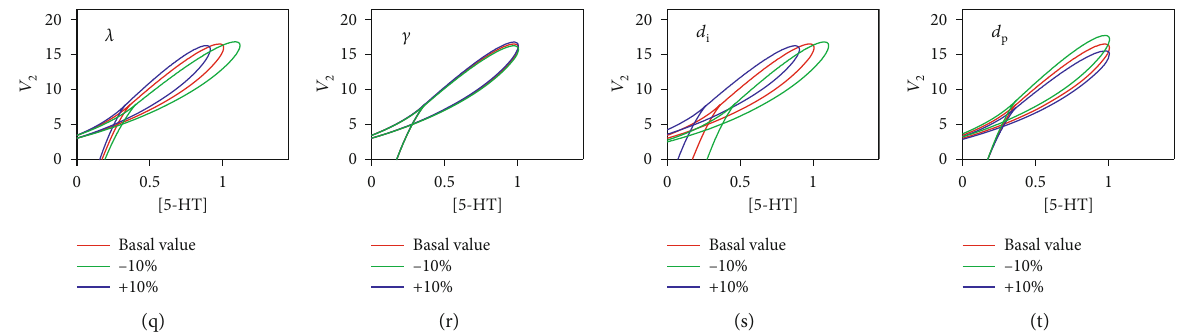
Þ plane. Red lines 2